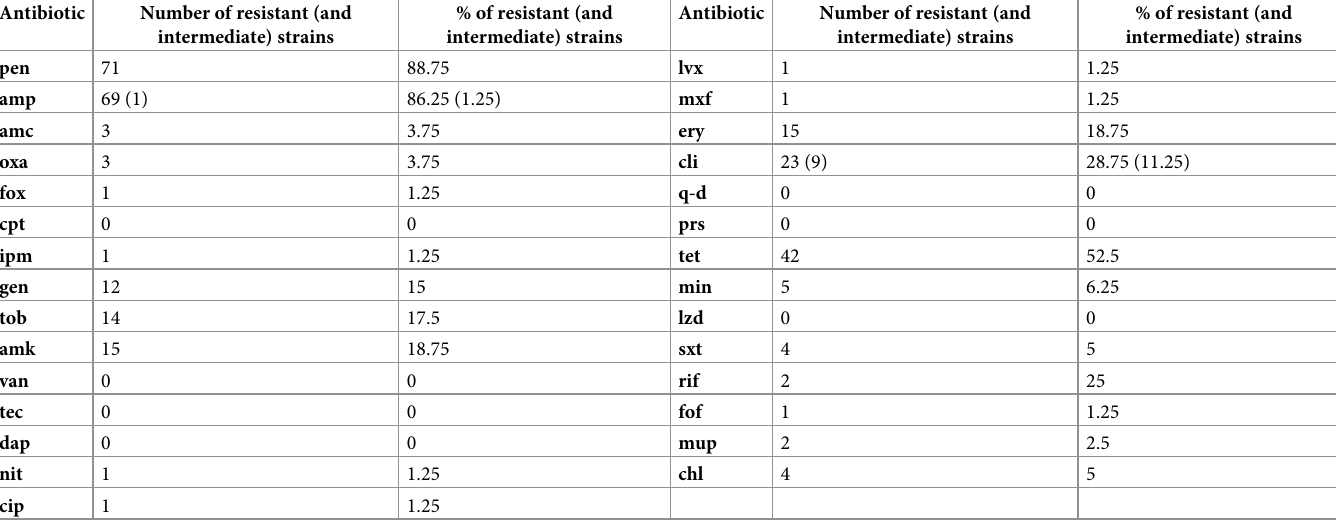
Table 1. Results of MicroScan analysis, showing number and percentage of resistance and intermediate susceptibility (in brackets) of S . aureus strains to different antibiotics (rows) pen: penicillin, amp: ampicillin, amc: amoxicillin + clavulanic acid, oxa: oxacillin, fox: cefoxitin, cpt: ceftaroline, ipm: imipenem, gen: gentamicin, tob: tobramycin, amk: amikacin, van: vancomycin, tec: teicoplanin, dap: daptomycin, nit: nitrofuorantoin, cip: ciprofloxacin, lvx: levofloxacin, mxf: moxifloxacin, ery: erythromycin, cli: clindamycin, q-d: quinupristin/dalfopristin, prs: pristinamycin, tet: tetracycline, min: minocycline, lzd: linezolid, sxt: trimethoprim-sulpha- methoxazole, rif: rifampicin, fof: fosfomycin, mup: mupirocin, chl: chloramphenicol. Antibiotic Number of resistant (and intermediate)